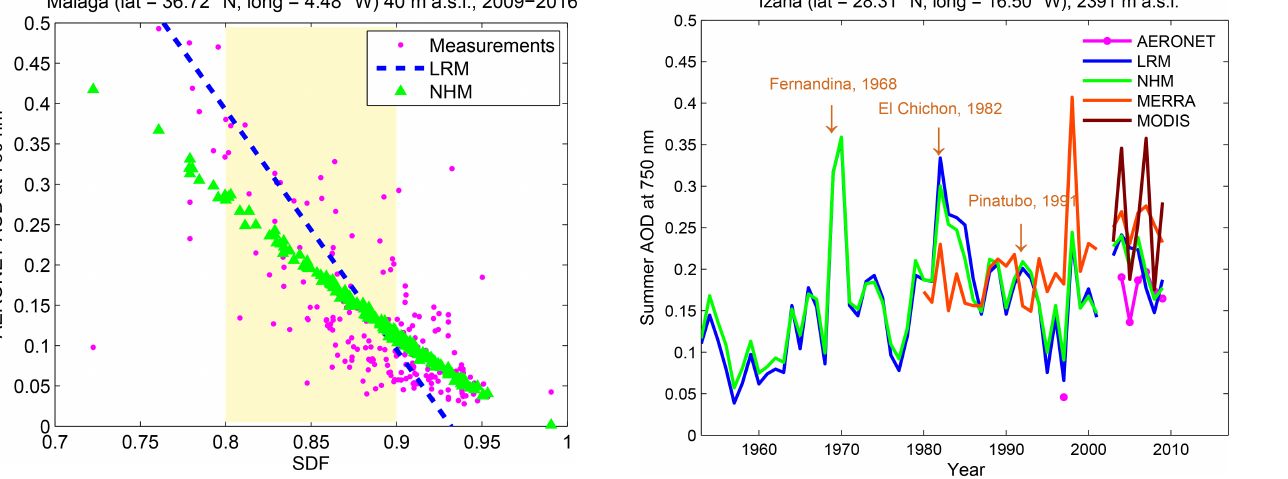
Figure 10. Time series of the summer means of AOD in Izaña,